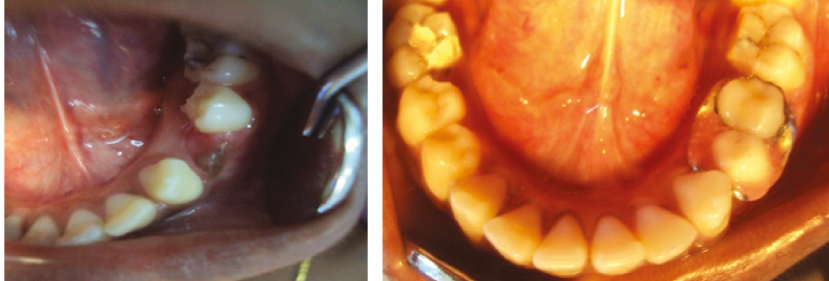
Figure 6: Preoperative and immediate postoperative occlusal views of the mandibular arch with the functional band and loop space maintainer in the tooth 34